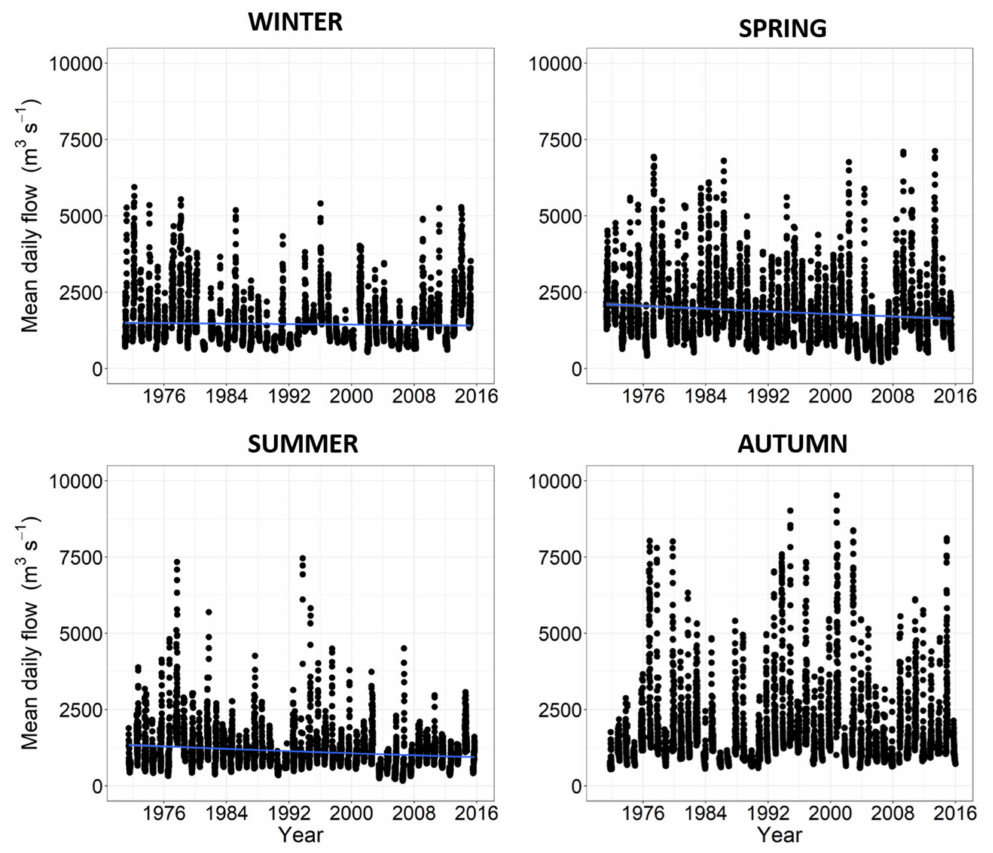
Figure 5. Seasonal trends of the daily Po River discharge (m 3 s − 1 ). The blue line represents the log-term regression. When the slope was not significant ( p -value > 0.05), the long-trend line was not reported. Data from the Pontelagoscuro station provided by the Servizio Idro-Meteo-Clima of Agenzia Regionale per la Protezione dell’Ambiente of the Emilia Romagna Region